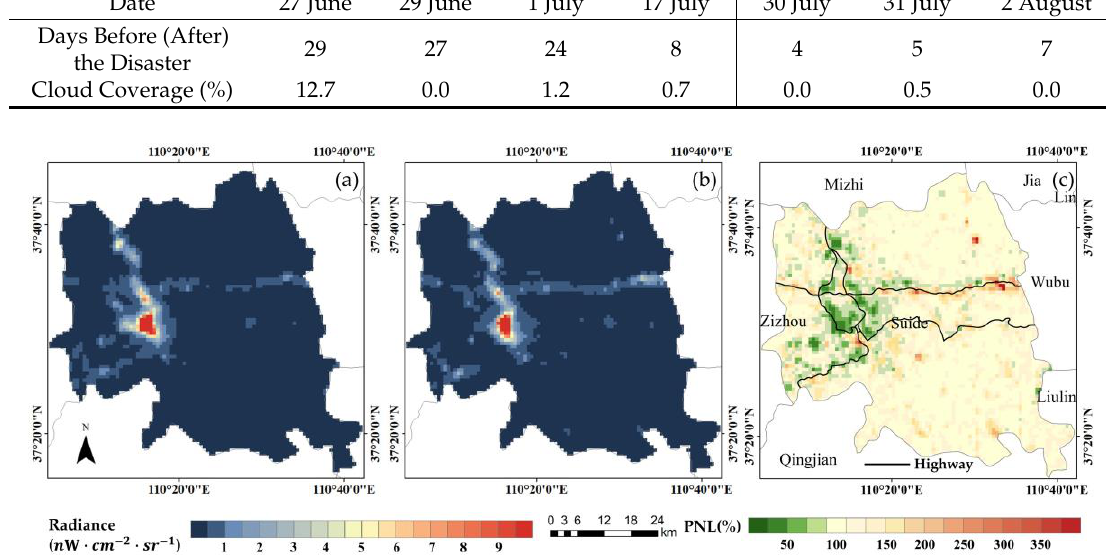
Figure 9. ( a ) The pre- and ( b ) post-flood averaging composite DNB images, and ( c ) the PNL image of the Yulin Flood.